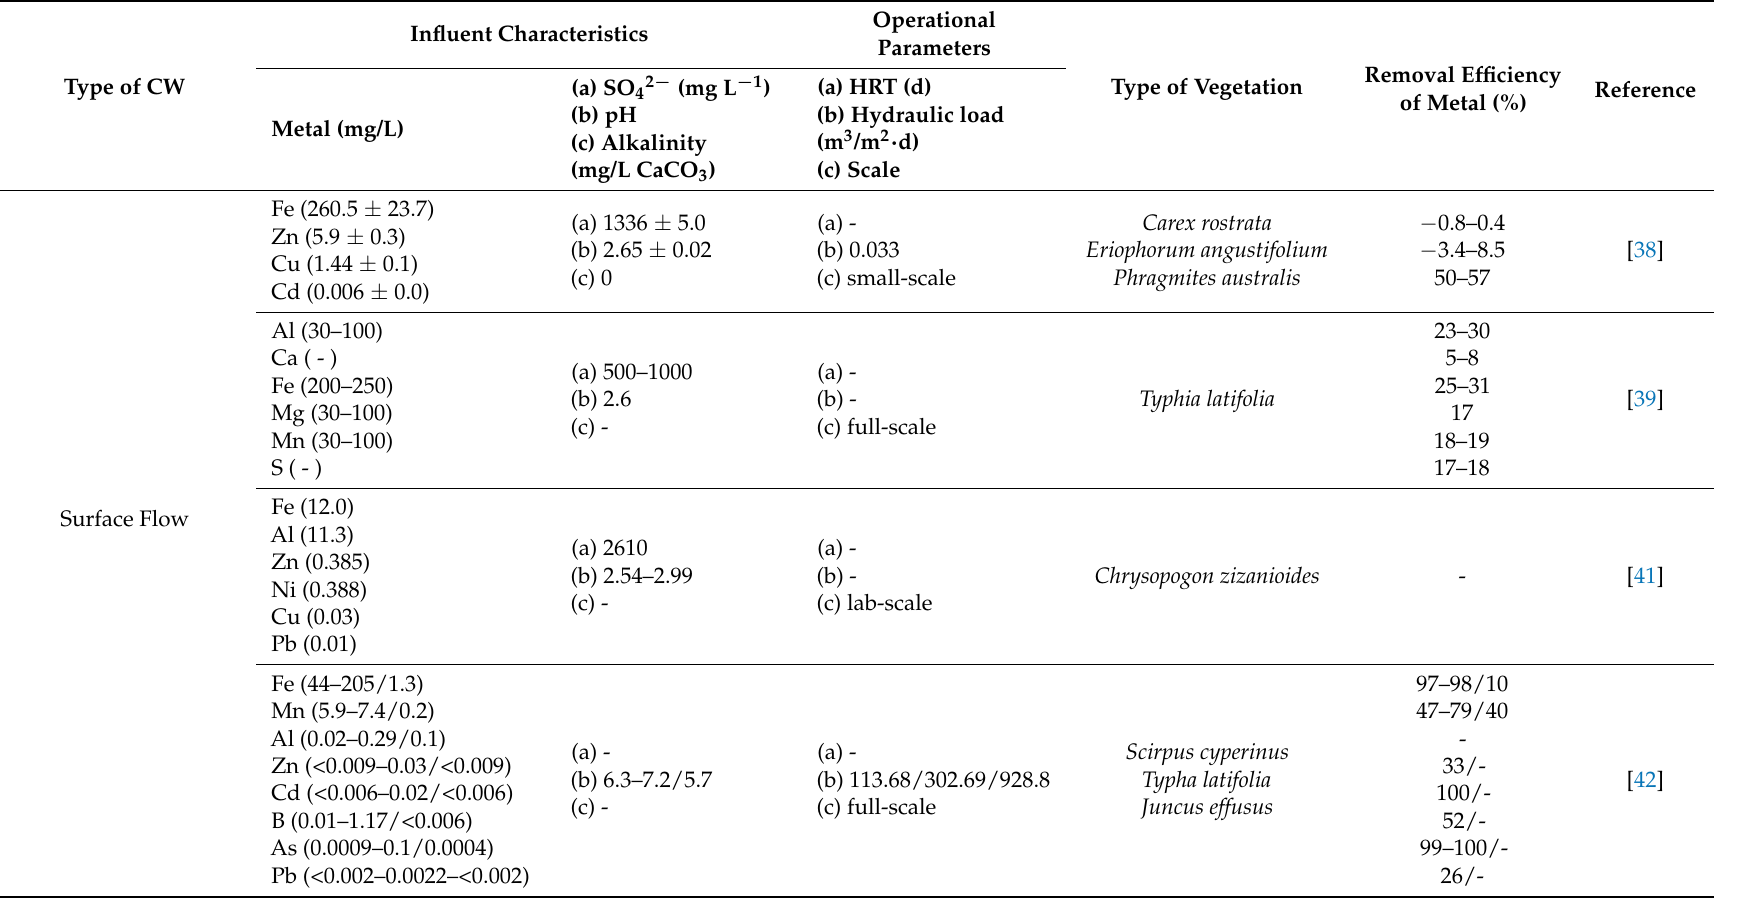
Table 2. Types of constructed wetlands applied to metal removal from acid mine drainage and their operational